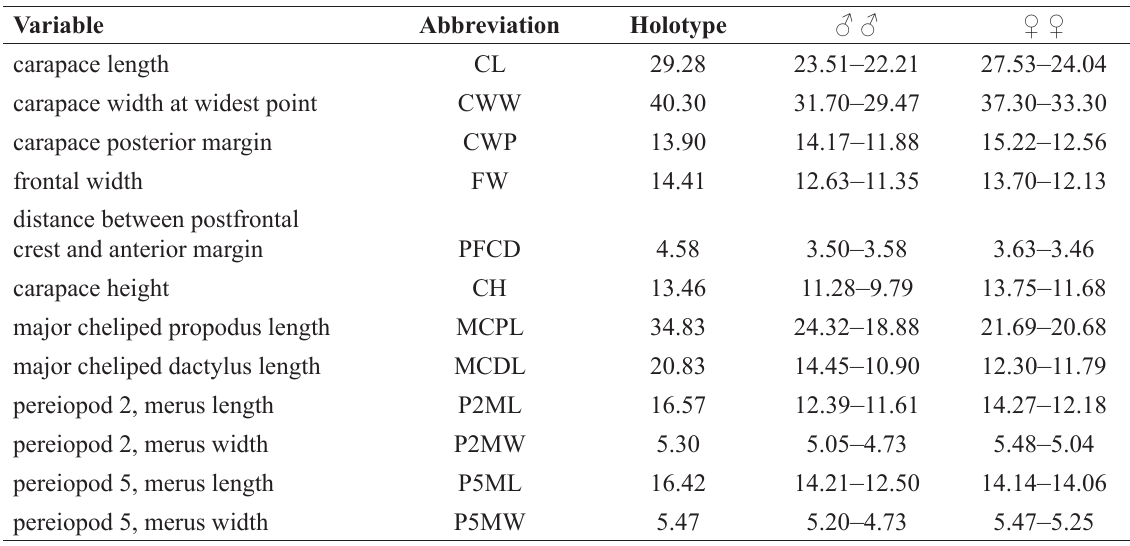
Table 1. Potamonautes baziya sp. nov., measurements (in mm) of the holotype and the range of additional male and female specimens